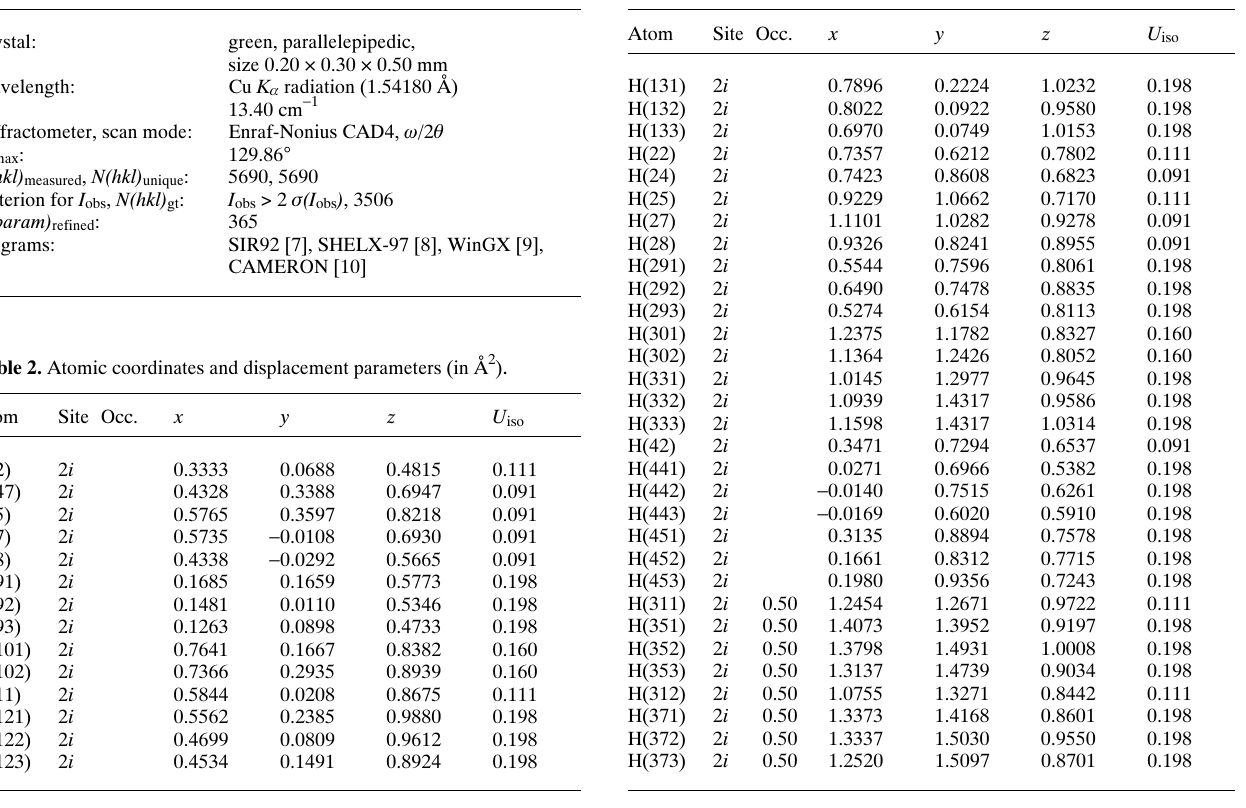
Table 1. Data collection and handling.